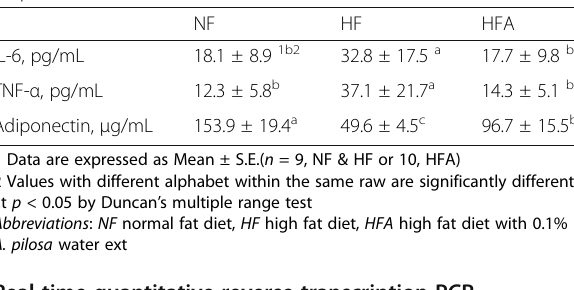
Table 4 The effect of A. pilosa on serum IL-6, TNF- α , and